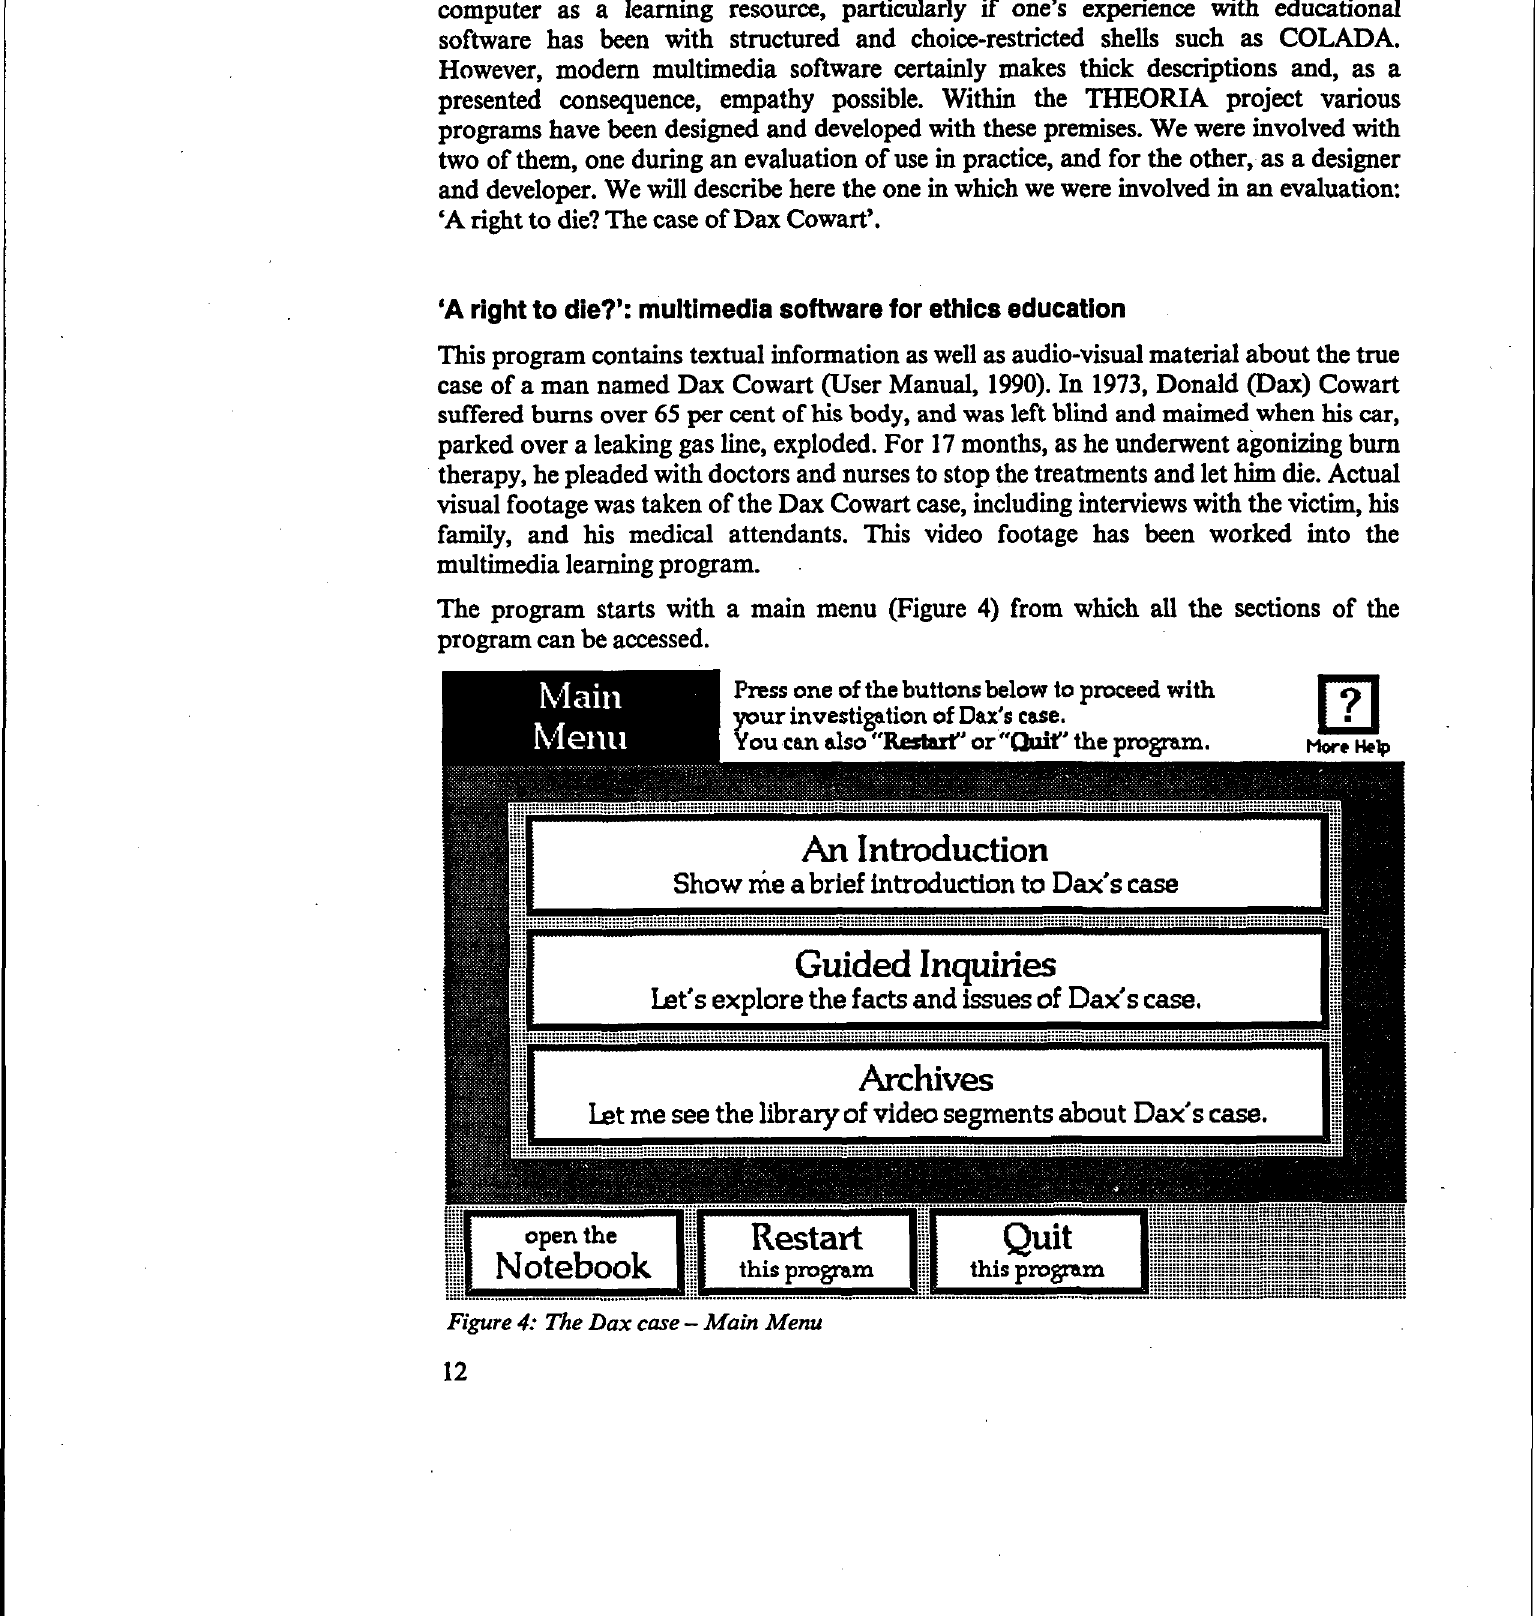
Figure 4: The Dax case - Main